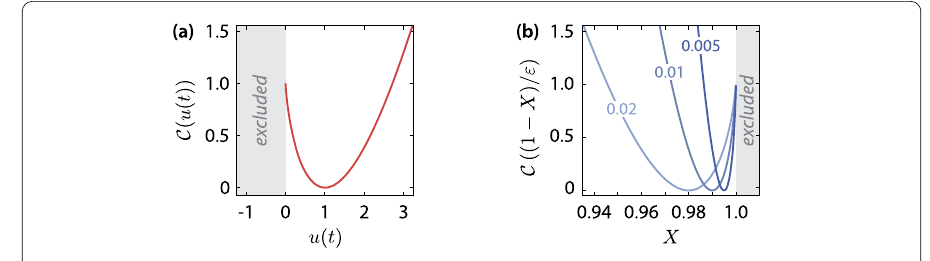
Figure 3 Plot of the cost functions for ( a ) minimal intermediate costs and ( b ) the enforcement of herd immunity at the end of the intervention for different values of ε . We use the short notation X = R 0 S ( T )/ N ( T ). The shaded region corresponds to unstable terminal